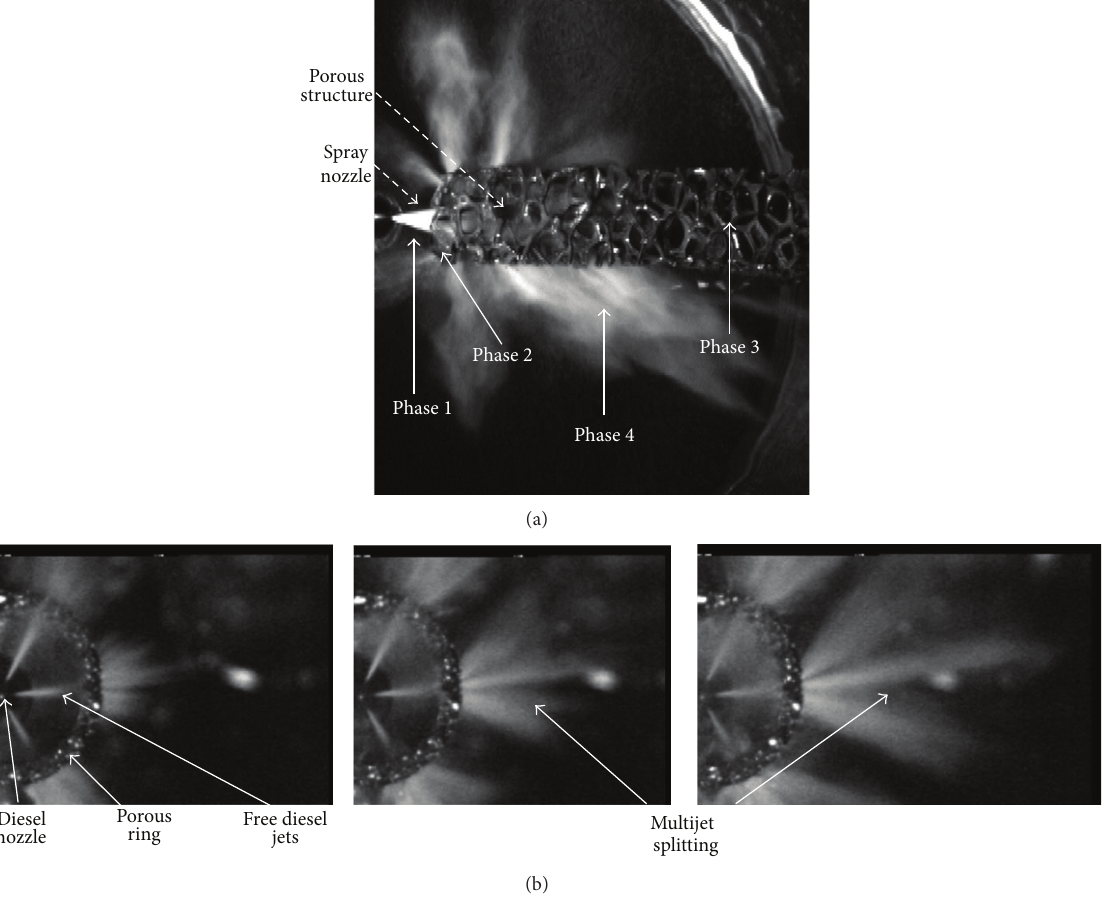
Figure 5: (a) Diesel spray interaction with highly porous structure; (b) example of a multijet splitting effect based on the interaction of Diesel spray with a porous structure (porous ring in the figure) at different time instances (at 𝑡 = 0 Diesel jet touches the inner surface of the porous